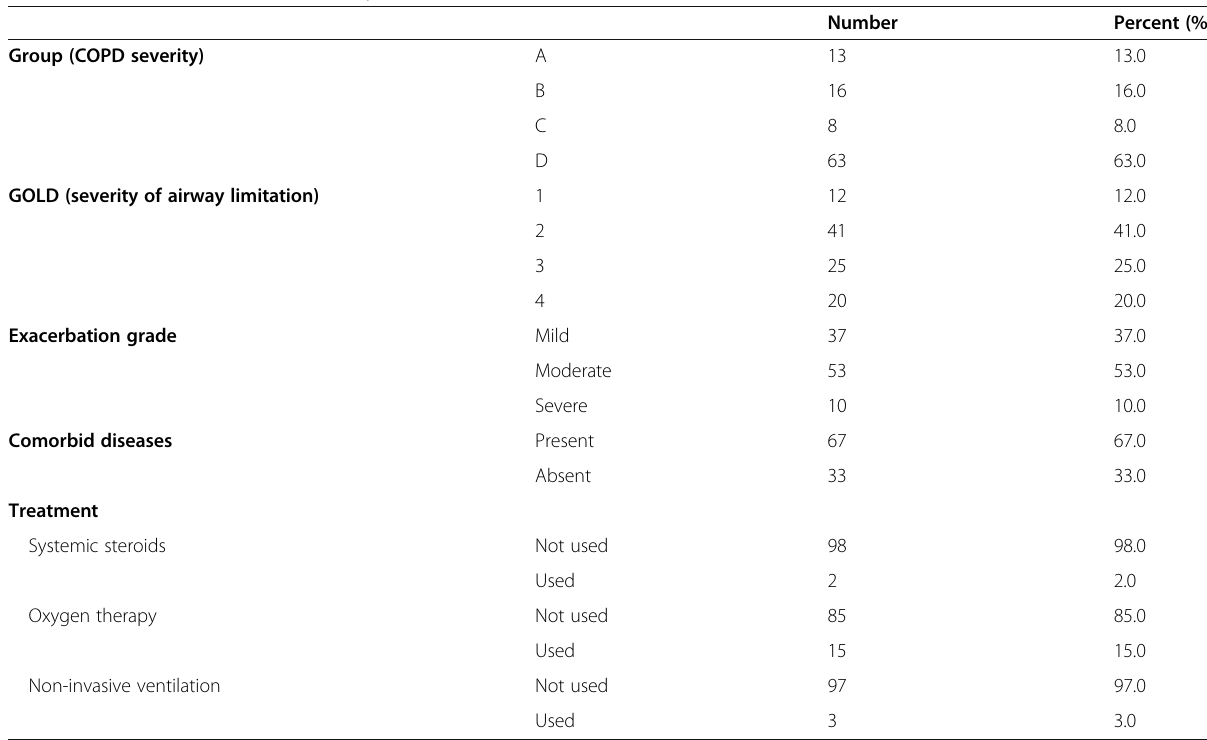
Table 2 Clinical assessment of studied patients